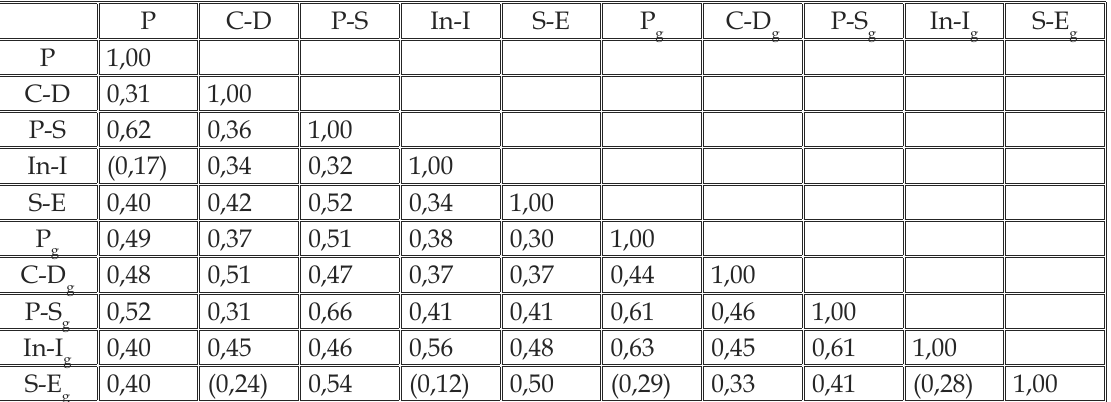
Table 3. Correlation matrix: the correlations that are not statistically signi (cid:222) cant for p <0.01 are provided in